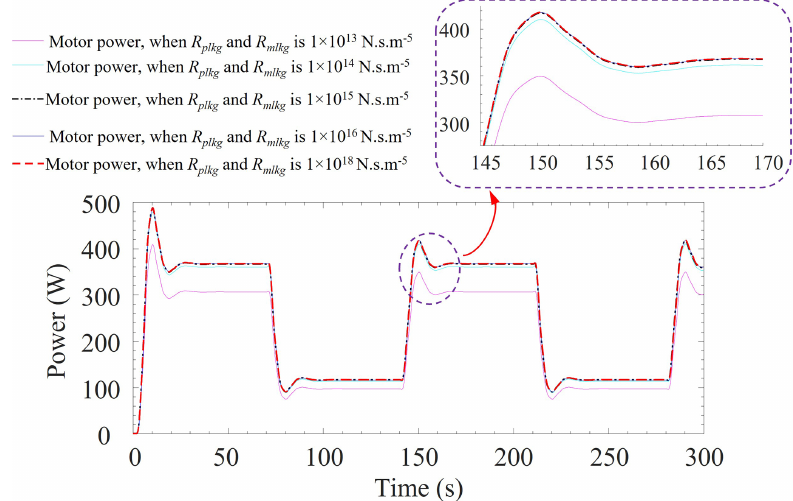
Figure 9. Influence of power output at motor shaft due to the variation of leakage resistance.